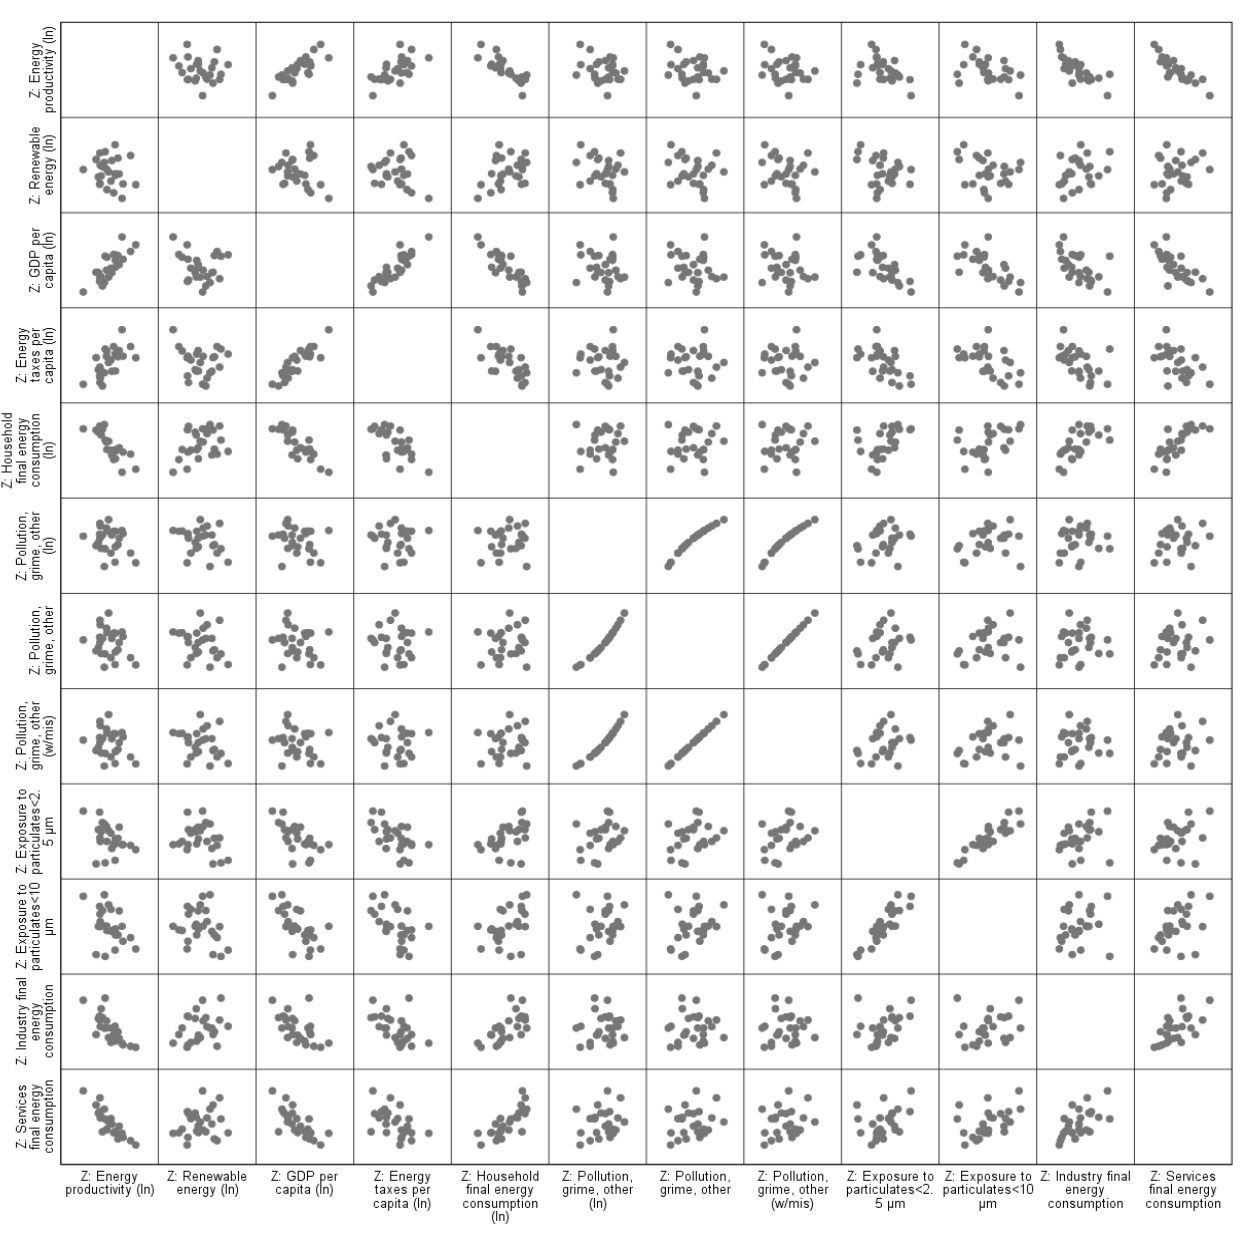
Figure 1. Bivariate relationship between variables in the dataset. Source: authors’ computation .